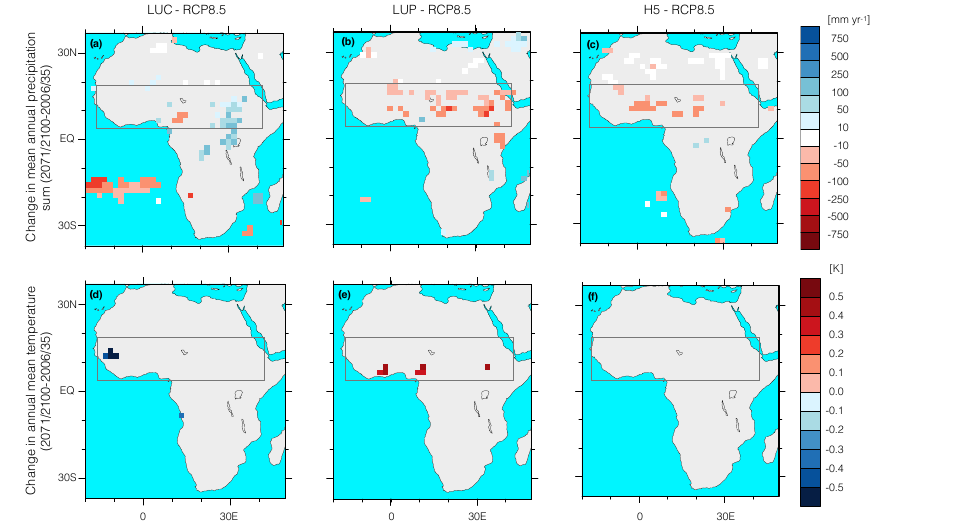
Fig. 7: Difference between the climate signal of the RCP8.5 scenario (three Figure 7. Difference between the climate signal of the RCP8.5 scenario (mean of the three ensemble members) and the land use experiments ensemble member mean) and the land use experiments LUC (a+c), LUP (b+e), LUC (a, c) and LUP (b, e) , and harvest experiment H5 (c, f) . Changes in mean annual precipitation sum (mmyr − 1 ) (a–c) and temperature and harvest experiment H5 (c+f). Changes in mean annual precipitation sum [mm (K) (d–f) are given for the last 30years of the scenarios (2071–2100). Non-significant (5%) differences are left out. yr -1 ] (a,b,c) and temperature [ K ] (d,e,f) are given for the last 30 years of the scenarios (2071/2100). Non significant (5%) di fferences are left out. perature changes are insignificantly small in the entire region under consideration (not